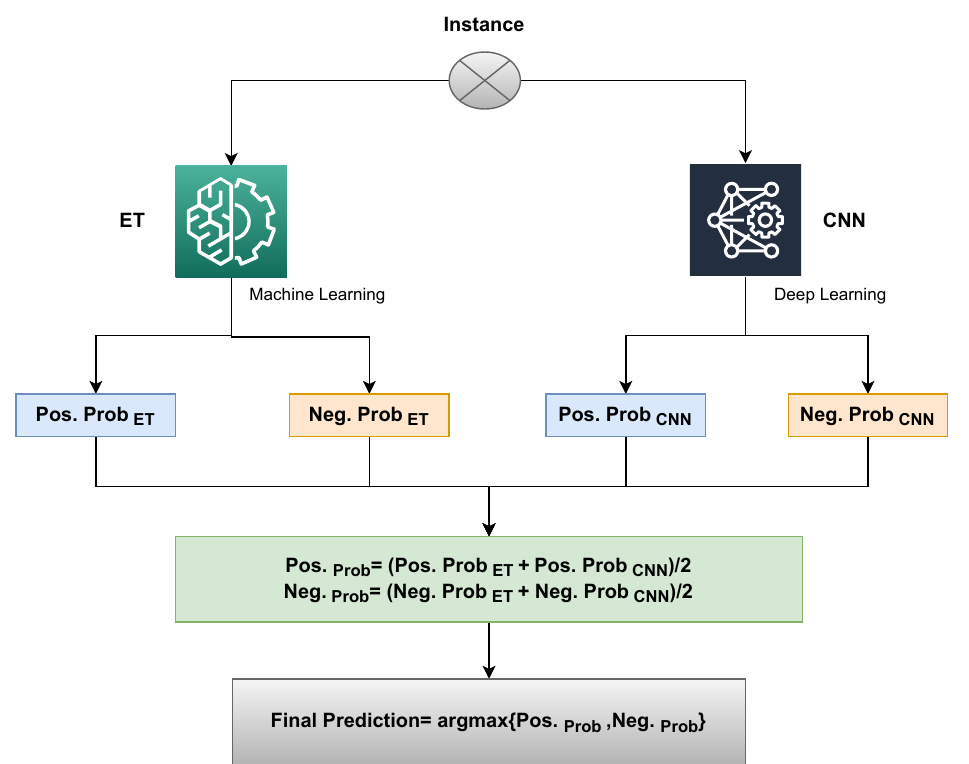
Figure 5. Architecture of the proposed